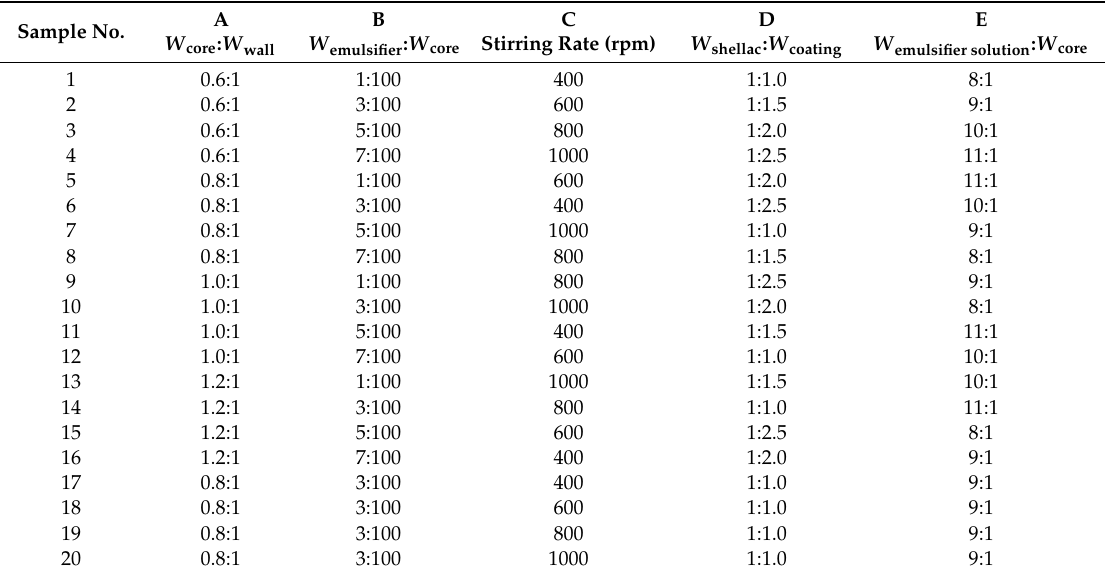
Table 2. Experimental